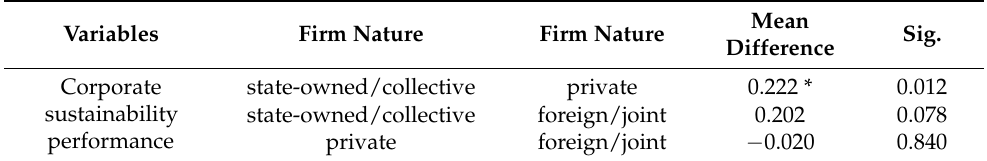
Table 4. LSD analysis results for different firm natures.